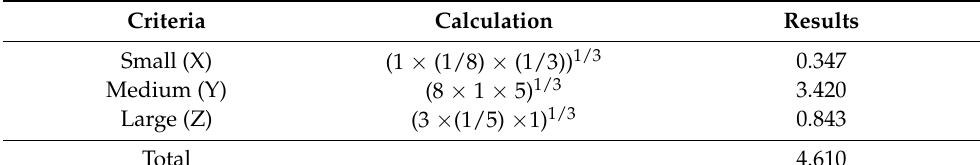
Table 16. Normalization table—A5.